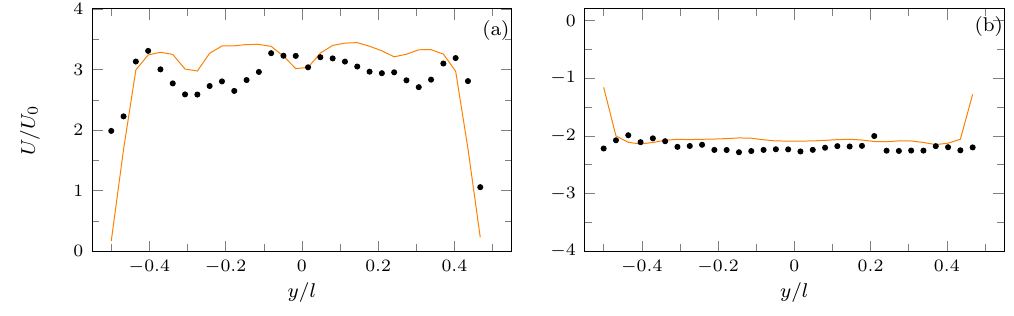
Figure 7. Phase-averaged streamwise velocity profiles along the spanwise y direction; slot 2, x / h = 0.2. ( a ) Expulsion peak ( t / T = 0.25); ( b ) Suction peak ( t / T = 0.75); numerical (solid line), experimental ( •